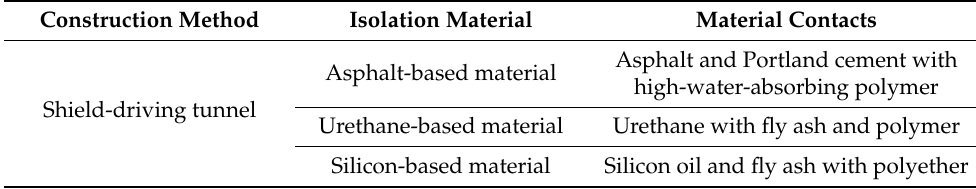
Table 2. Types of seismic isolation materials